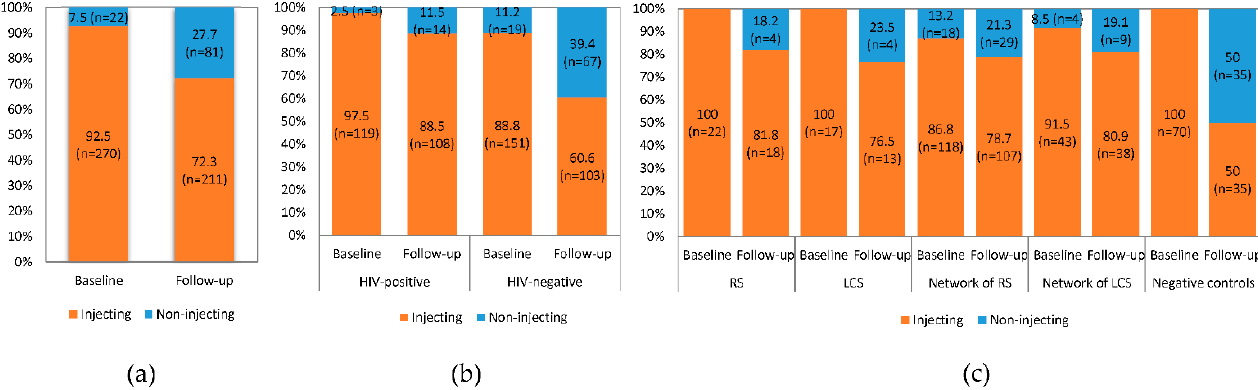
Figure 1. Frequencies of the responses to questionnaire item Q1 (Have you injected drugs, or had someone other than an accredited professional inject you with any drugs?) ( n = 292), at baseline and follow-up of Transmission Reduction Intervention Project (TRIP) ( a ) all participants, ( b ) by human immunodeficiency virus (HIV) status, and ( c ) by participant group . Abbreviations: RS, recent seeds; LCS, control seeds with long ‐ term HIV infection.